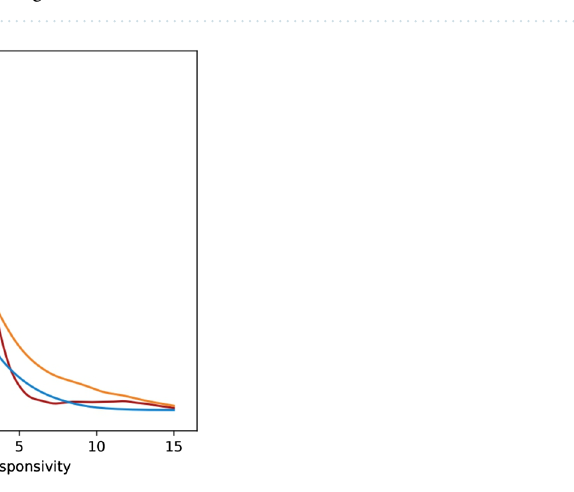
objects and decreased responses to scrambling.